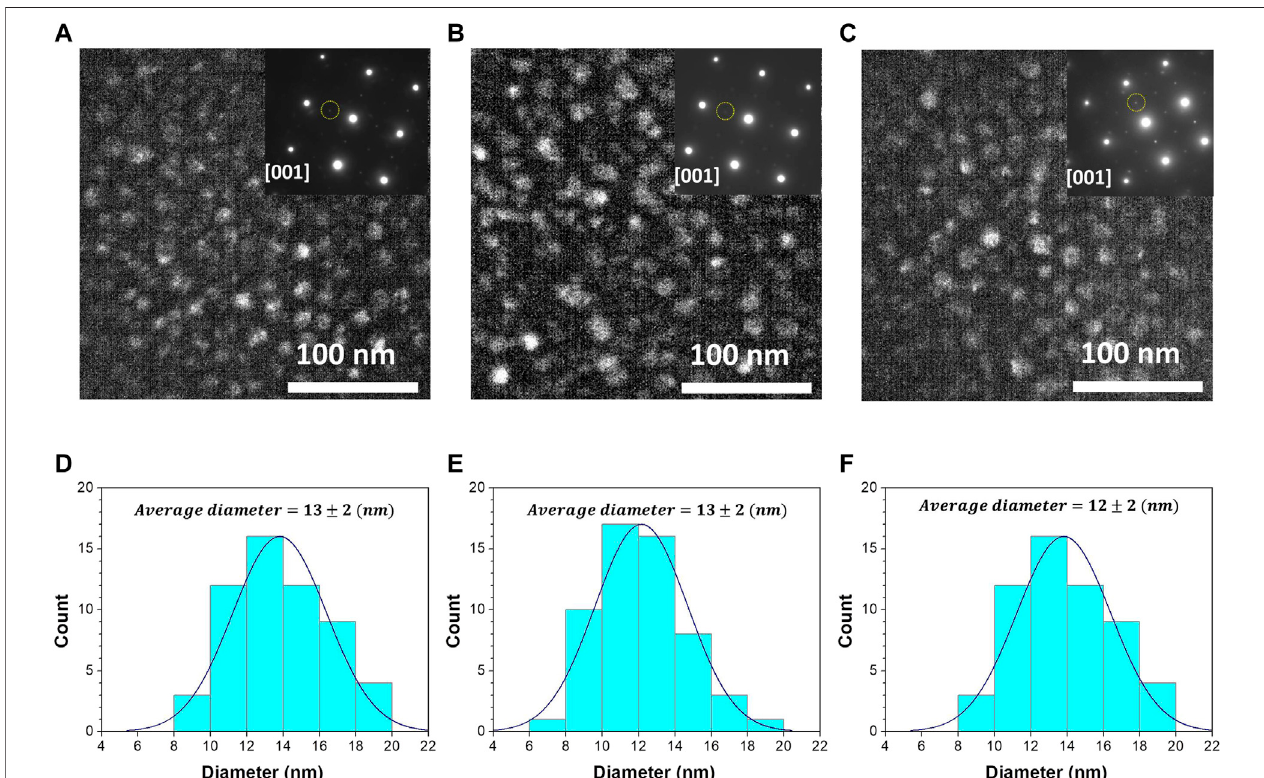
FIGURE 1 | (A – C) The DF-TEM images of the alloy Ni 2 CoFeCrTi 2 Al 1 , Ni 2 CoFeCrTi 1.5 Al 1.5 , and Ni 2 CoFeCrTi 1 Al 2 respectively. The insets are the SADP along zone- axis z = [001]. (D – F) The size distributions of the γ ′ nanoparticles in the corresponding DF-TEM images.